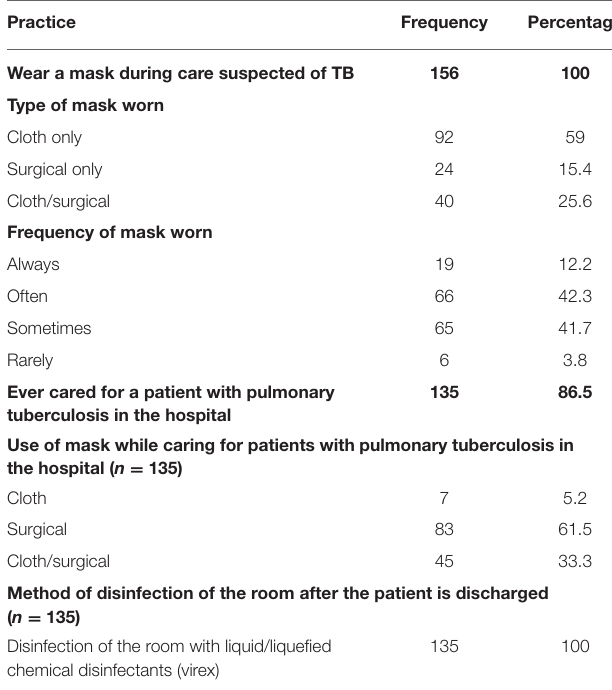
TABLE 4 | Practice of TB infection and prevention among nurses n = 156.